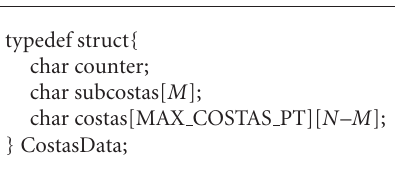
typedef struct { char counter; char subcostas[ M ];